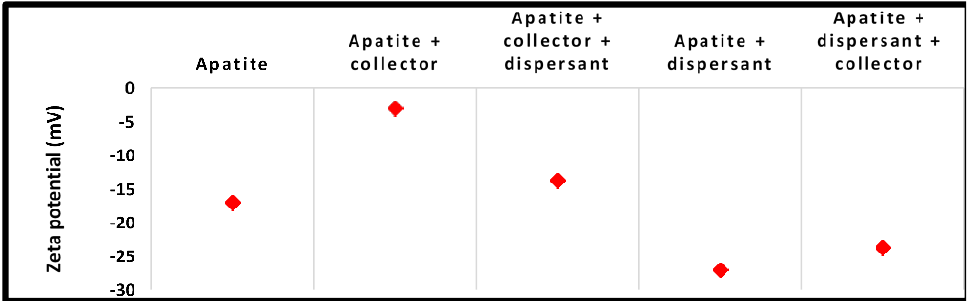
Figure 7. Zeta potential of ( A ) apatite and ( B ) quartz before and after mixing with different reagents at pH 9. Minerals 2017 , 7 , 145 9 of 14